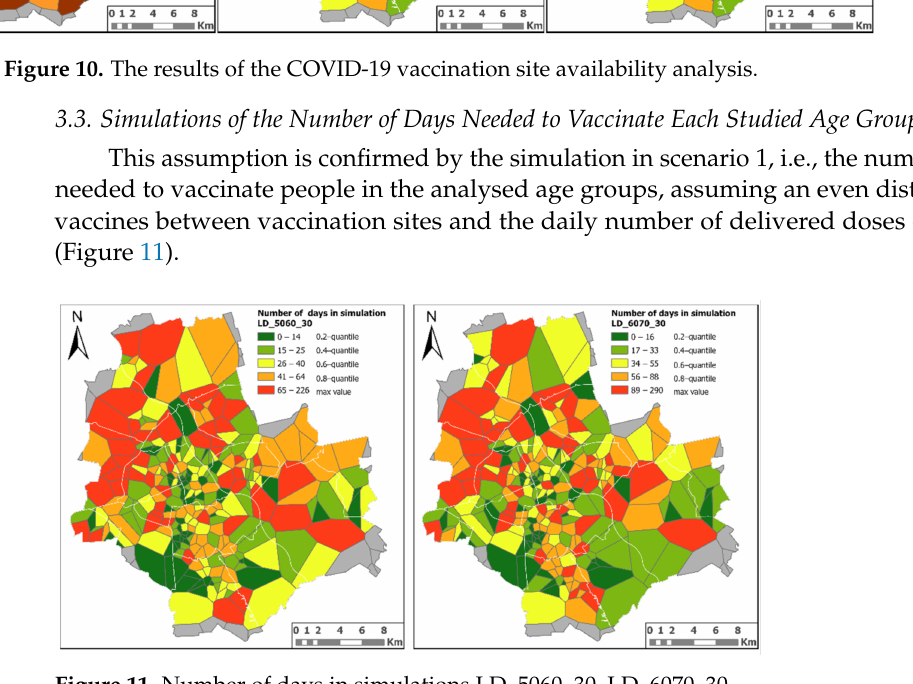
Figure 11. Number of days in simulations LD_5060_30,